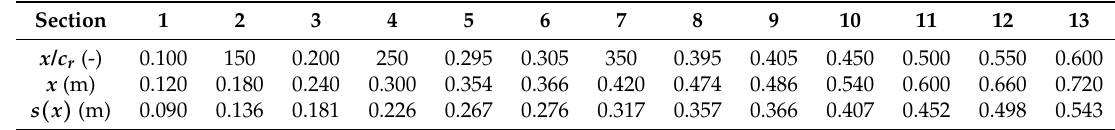
Table 2. Chordwise sections for particle-image-velocimetry (PIV).